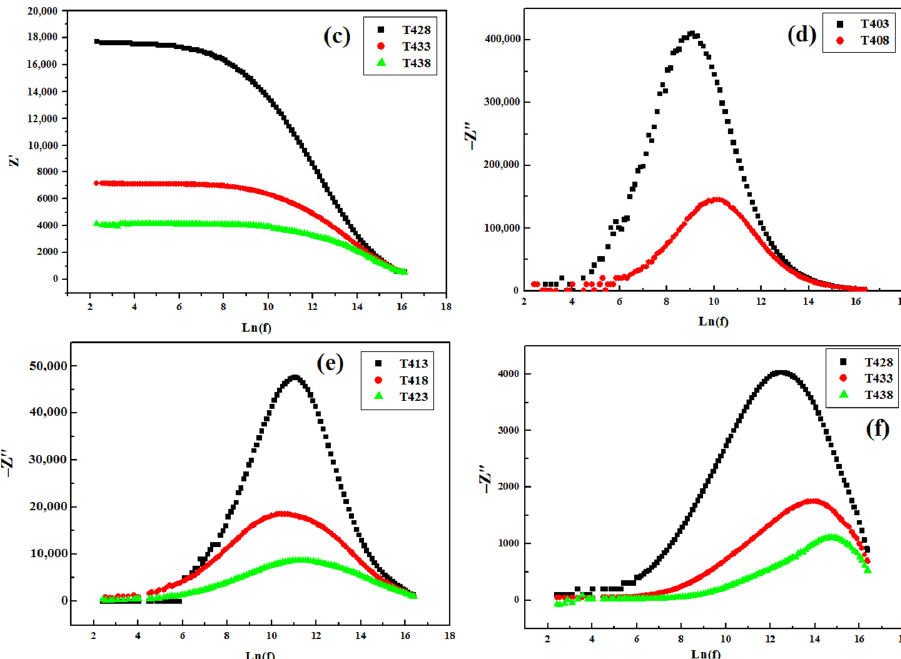
Figure 11. ( a ) Z’ versus Ln(f) in the range 403-408 K; ( b ) Z’ versus Ln(f) in the range 413-423 K; ( c ) Z’ Figure 11. (a) Z’ versus Ln(f) in the range 403-408 K; (b) Z’ versus Ln(f) in the range 413-423 K; (c) Z’ versus Ln(f) in the range 428-438 K; (d) − Z ″ versus Ln(f) in the range 403-408 K; (e) − Z ″ versus versus Ln(f) in the range 428-438 K; ( d ) − Z” versus Ln(f) in the range 403-408 K; ( e ) − Z” versus Ln(f) Ln(f) in the range 413-423 K; (f) − Z ″ versus Ln(f) in the range 428-438 K. in the range 413-423 K; ( f ) − Z” versus Ln(f) in the range 428-438 K.